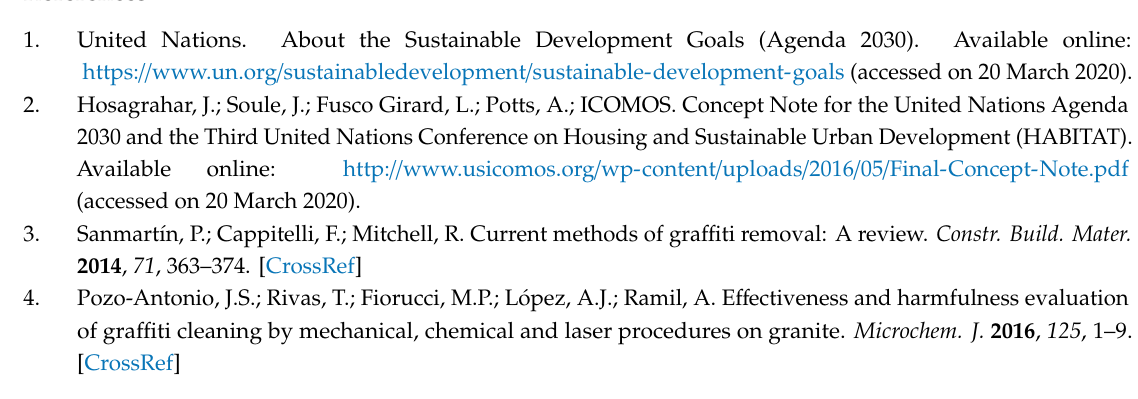
Table S1: Roughness parameter R 3z ( µ m) of the uncoated stone and the surfaces coated with either the sacrificial or the permanent anti-gra ffi ti after being cleaned with the respective products. n = 3. Standard deviation are also shown, Table S2: Water absorption ( W a, kg · s / m 2 ) of the uncoated stone and the surfaces coated with either the sacrificial or the permanent anti-gra ffi ti after being cleaned with the respective products. n = 3. Standard deviations are also shown, Table S3: Static contact angle ( ◦ ) of the uncoated stone and the surfaces coated with either the sacrificial or the permanent anti-gra ffi ti after being cleaned the respective products. n = 3. Standard deviations are also